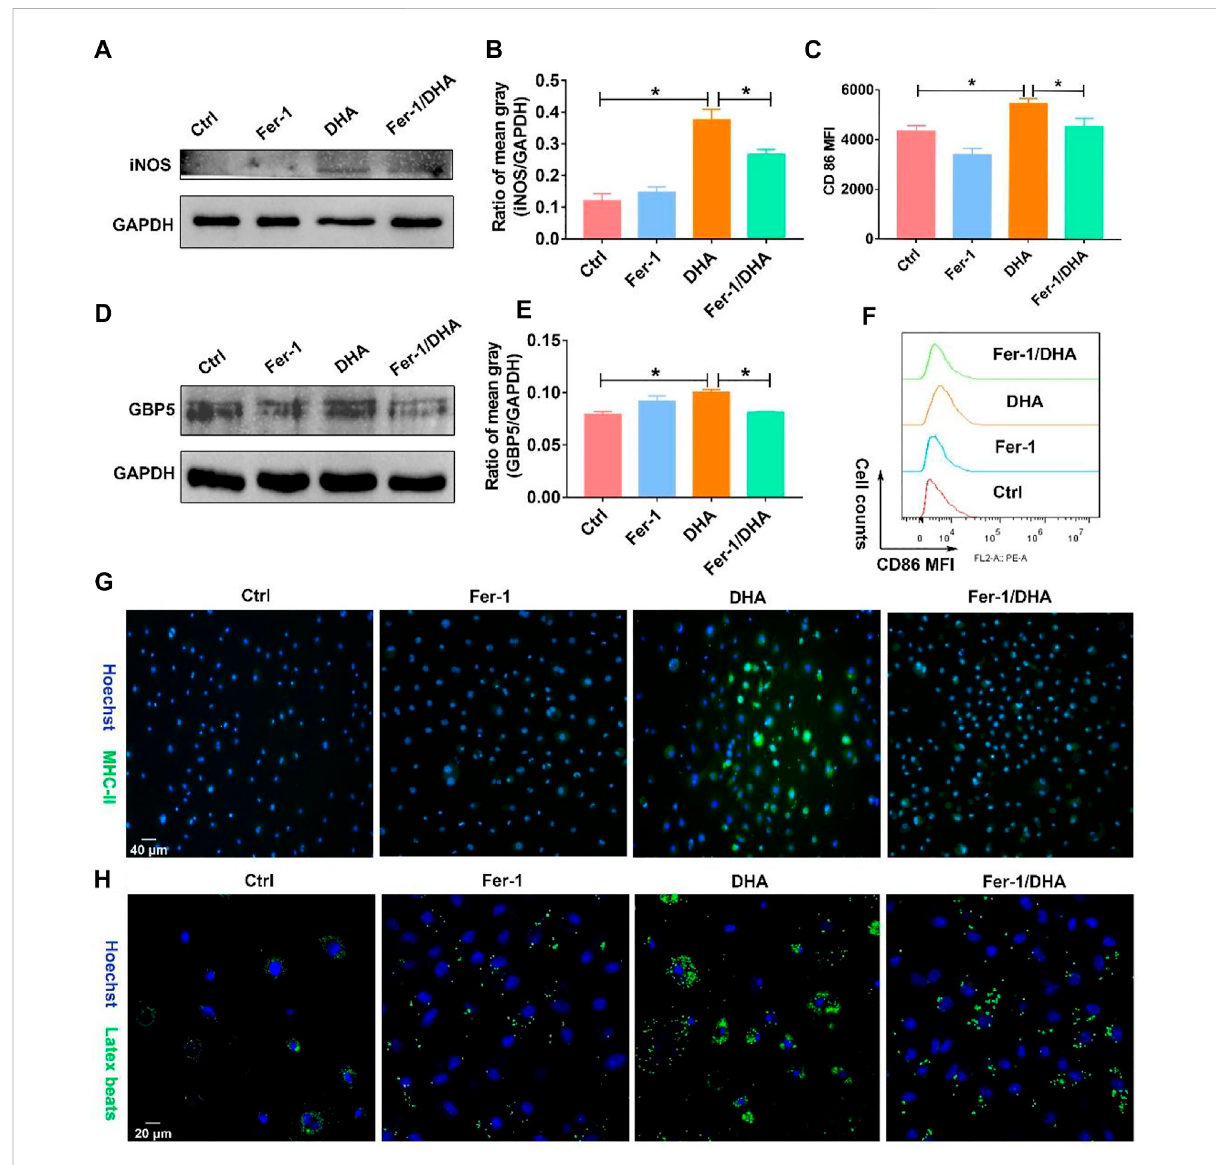
FIGURE 8 Fer-1 suppressed the remolding effect of TAM toward the M1 phenotype induced by DHA. (A,B) iNOS expression in TAM was measured using WB. The mean gray was quantitatively analyzed. (D,E) GBP5 expression in TAM was measured using WB. The mean gray was quantitatively analyzed. (C – F) The CD86 expression of TAM was analyzed through fl ow cytometry. (G,H) MHC-II immuno fl uorescent staining and latex beats assay were applied to demonstrate the antigen presentation ability and phagocytosis function. Geometric means were used to quantify the MFI. Values were means ± SD ( n = 3, * p <